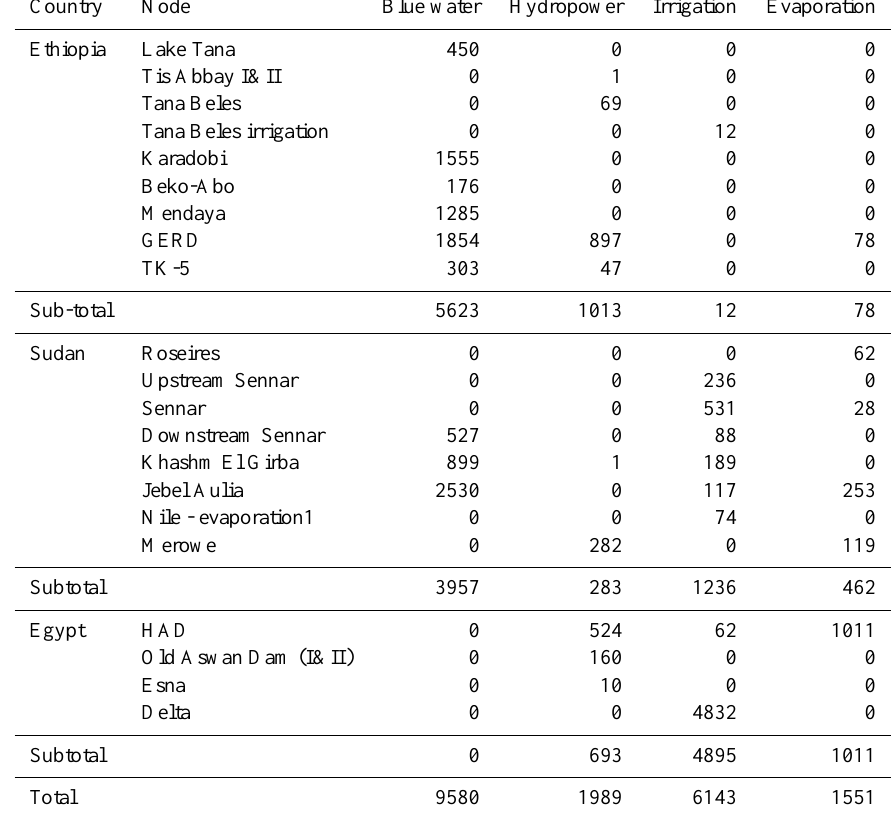
Table 2. Annual water accounts in USD million – Eastern Nile Basin. Country